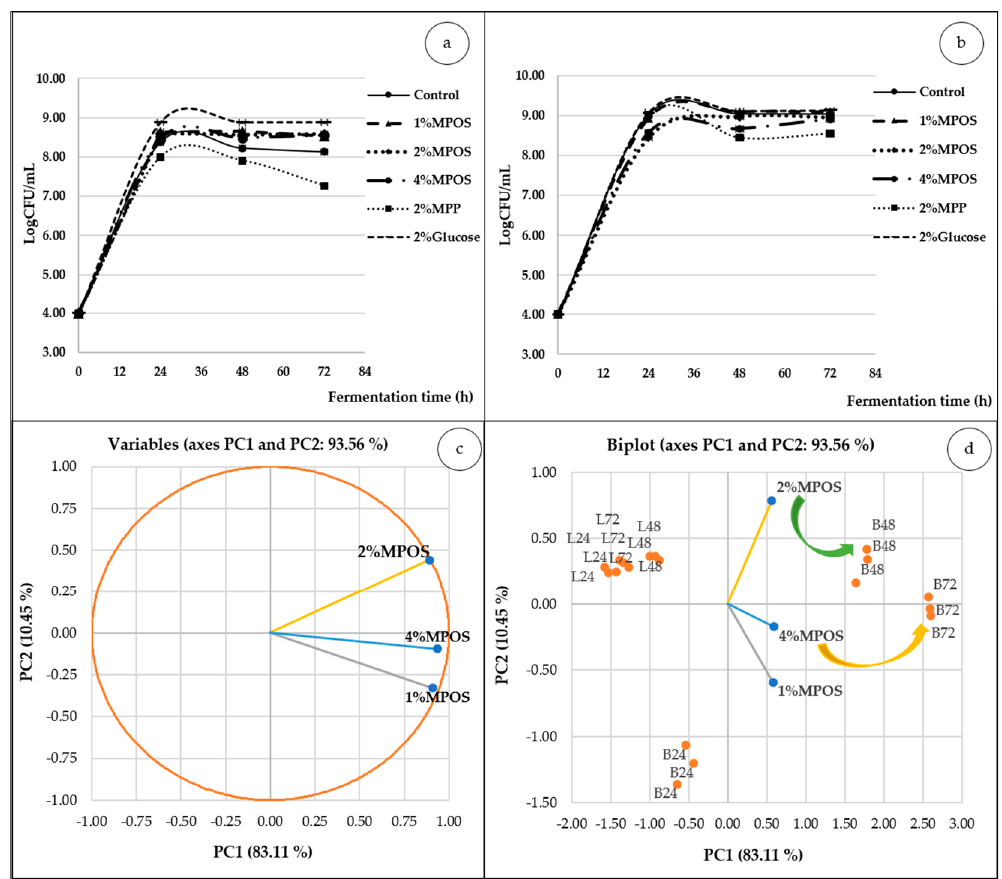
Figure 3. The populations (log CFU/mL) of L. reuteri DSM 17938 ( a ) and B. animalis TISTR 2195 ( b ) inoculated at 4 log CFU/mL in the medium supplemented with different carbon sources. The chemometric PCA (( c ) = score plot and ( d ) = biplot) illustrates the relationship between prebiotic concentration and probiotic growth (L = L. reuteri and B = B. animalis ) at each fermentation time (24, 48 and 72 h). Error bars represent standard deviation ( p < 0.05).